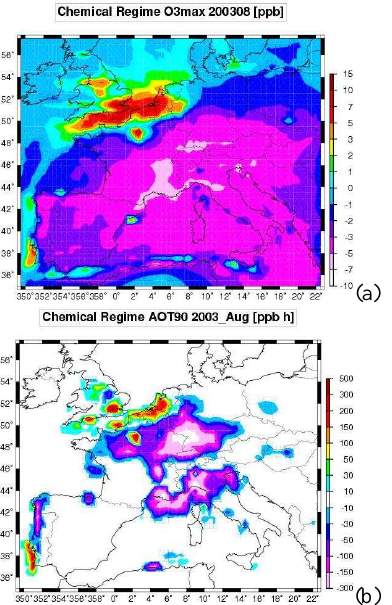
Fig. 6. Chemical regime simulations for August 2003: (a) chemical regime for daily ozone maximum, (b) chemical regime for AOT90.